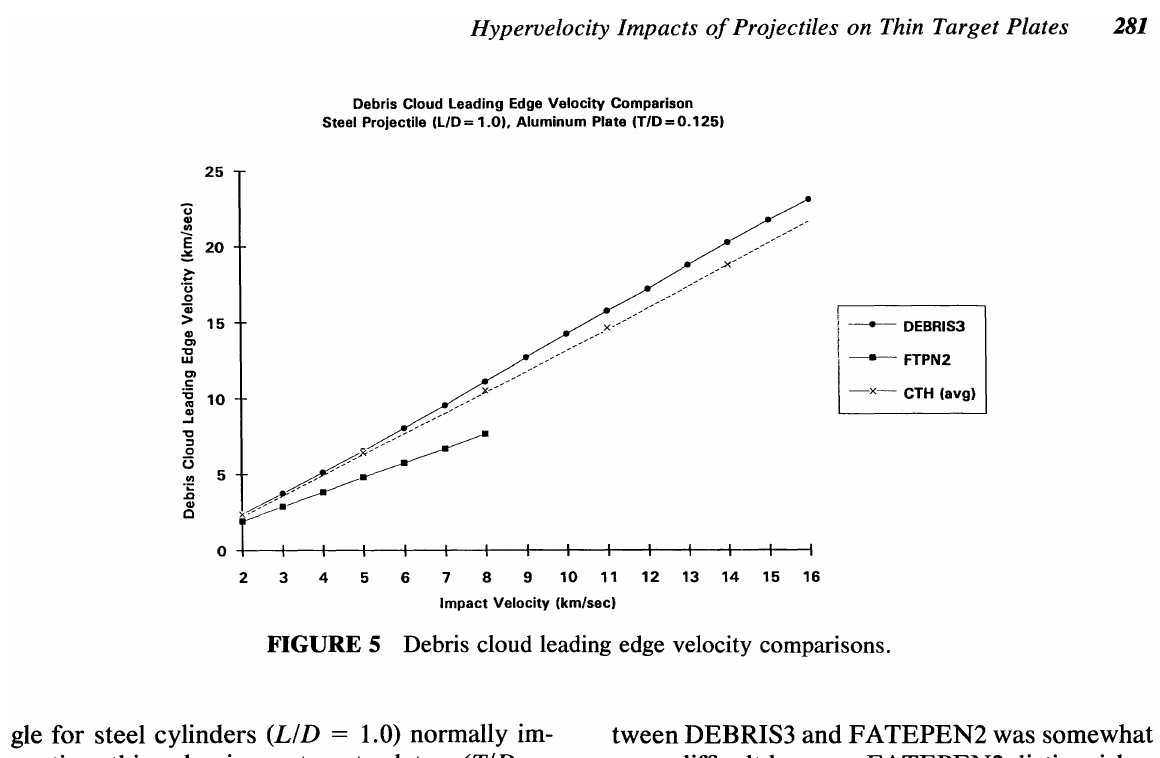
FIGURE 5 Debris cloud leading edge velocity comparisons.